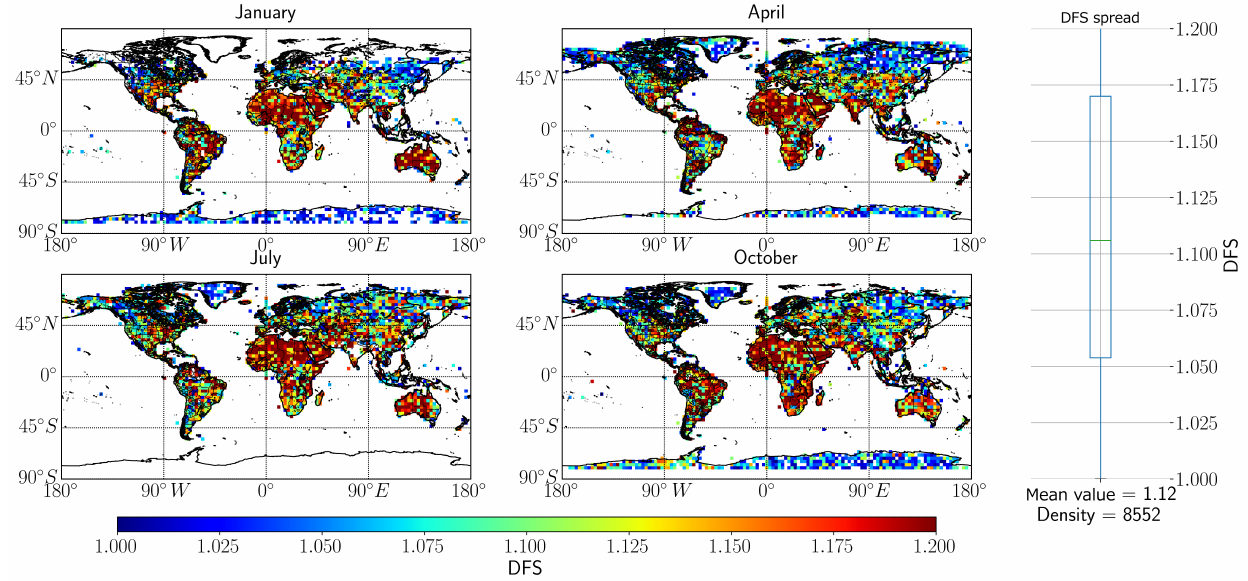
Figure 13. As Figs. 3 and 9 but focused on a combination of the SWIR channels from Sentinel-5.